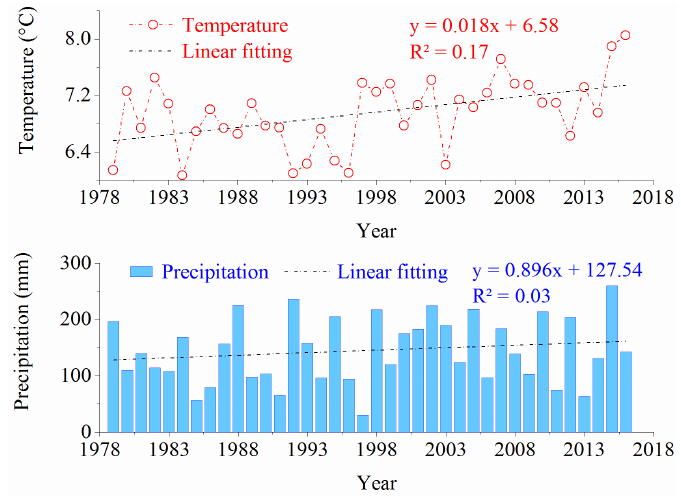
Figure 9. Variation of the annual temperature and precipitation from 1979 to 2016. To further explore the relationship between the corrected meteorological data (temperature and precipitation) and runoff, we compared the accumulated difference curves of the temperature, precipitation, total runoff, Qsim_rain, Qsim_glacier and Qsim_snow (Figure 10). The results showed that the runoff in period I (1979 to 1989) showed a downward trend, affected by the decrease in temperature and precipitation. Secondly, the total runoff entered the lowest period in period II (1990 to 1997), affected by the decrease in precipitation and glacial runoff due to the decrease in air temperature. A higher glacier mass balance also emerged in this period. In period III (1998 to 2016), the temperature showed a significant upward trend while the precipitation increased sharply from 1998 to 2004 and was generally stable after 2004. Thus, the snowmelt runoff and glacial runoff increased significantly under the influence of increased temperature,